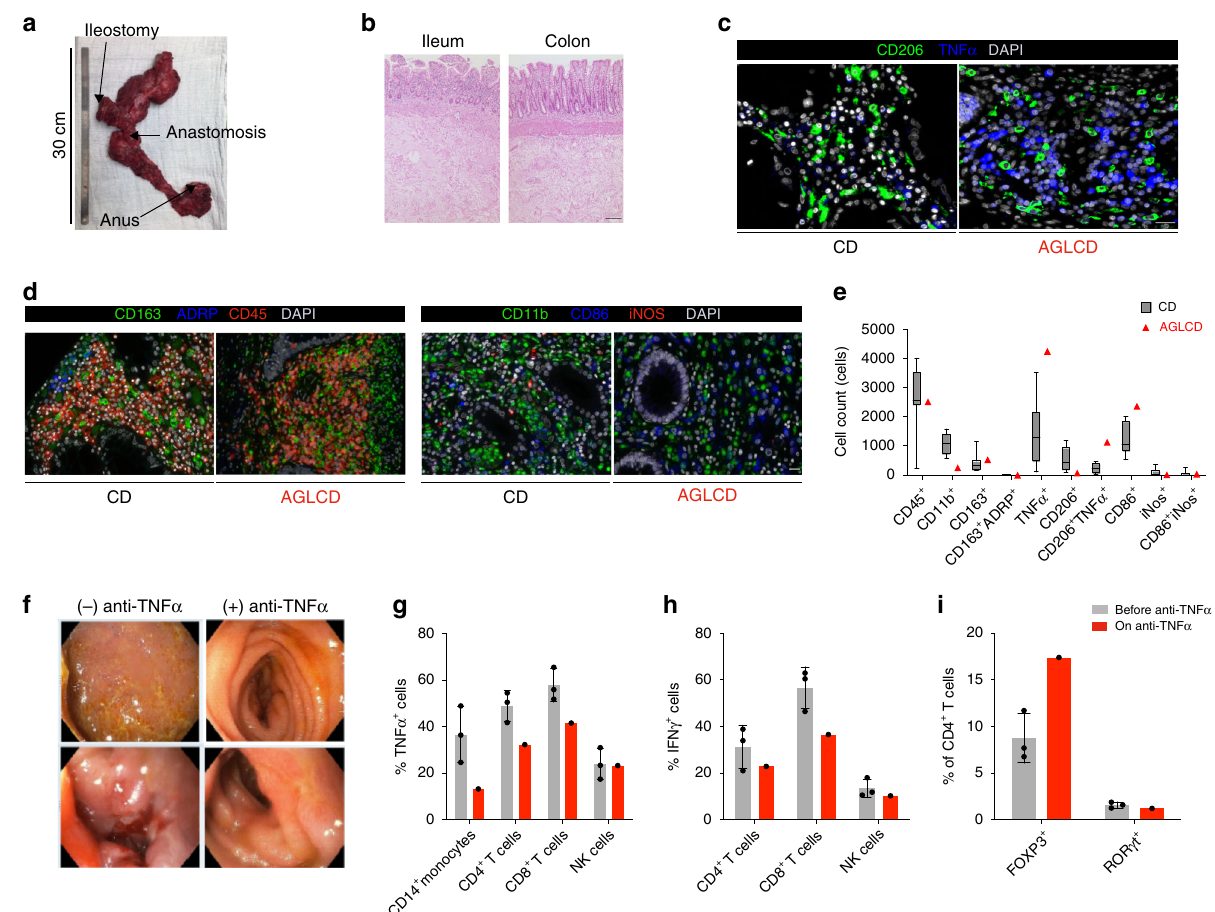
Fig. 4 TNF α -driven intestinal in fl ammation during rLeptin treatment is reversed by anti-TNF α therapy. a – e Sustained in fl ammation under rLeptin substitution and previously acquired structural damage (stenosis and fi stula-induced abscess) made proctocolectomy and ileal resection necessary 16 days after initiation of rLeptin therapy. The specimen ( a ) was analyzed histologically by H&E staining (scale bar depicts 100 µ m) ( b ), showing severe in fl ammation, and by immunohistochemistry (IHC; c – e ). c Microscopic pictures of IHC staining for TNF α and CD206 in gut tissue from the AGLCD patient and a Crohn ’ s disease (CD) patient (The scale bar depicts 20 µ m, images were recorded using an AxioImager Z1 from Zeiss). d Additional pictures of IHC staining for different immune cell markers (recorded with the Vectra3 system from PerkinElmer, the scale bar displays 20 µ m) and ( e ) quanti fi cation of cells staining positive for respective markers per 10 high power fi elds (For CD45, CD163 and ADRP stainings a total of 11 tissue samples from n = 7 biologically independent CD control patients was compared to the AGLCD patient ( n = 1); for TNF α and CD206 stainings a total of 9 samples of n = 6 independent CD patients was obtained and compared to the AGLCD patient ( n = 1); for CD11b, CD86 and iNOS stainings a total of 6 samples from n = 3 biologically independent CD patients was compared to the AGLCD patient ( n = 1); in case that several samples were analyzed from the same patients,